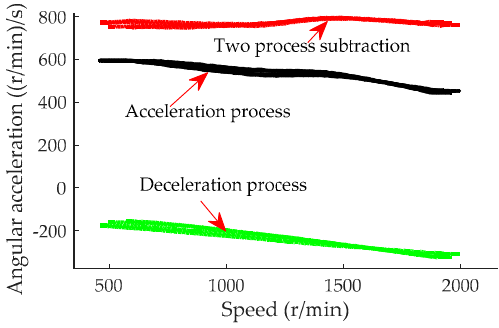
Figure 9. Angular acceleration of engine acceleration and deceleration.